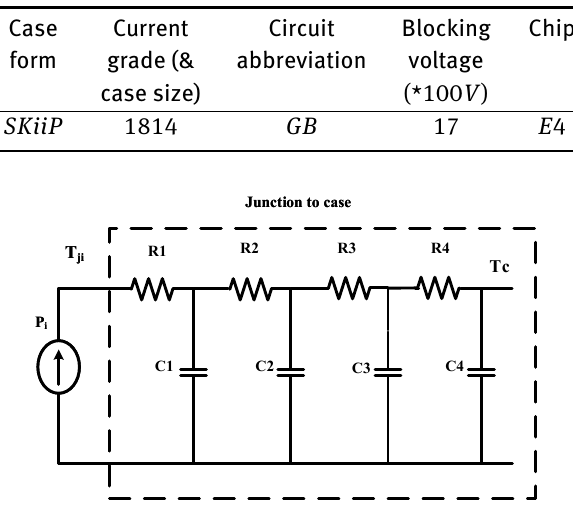
Figure 18: Cauer thermal impedance between the junction tempera- ture and case layer.